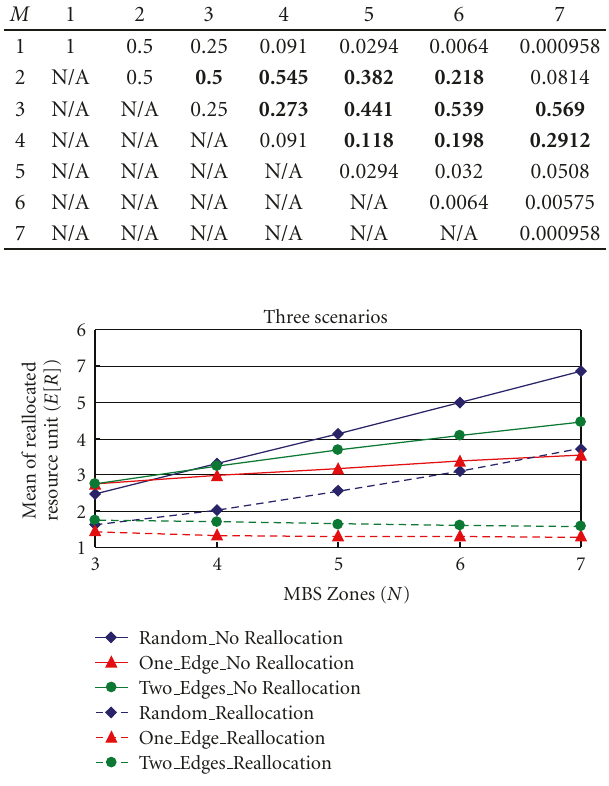
Figure 7: Performance of the radio resource reallocation algorithm.